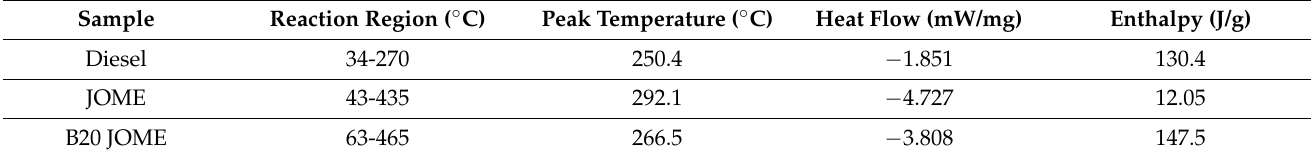
Table 4. Heat flow and enthalpy at peak temperature.